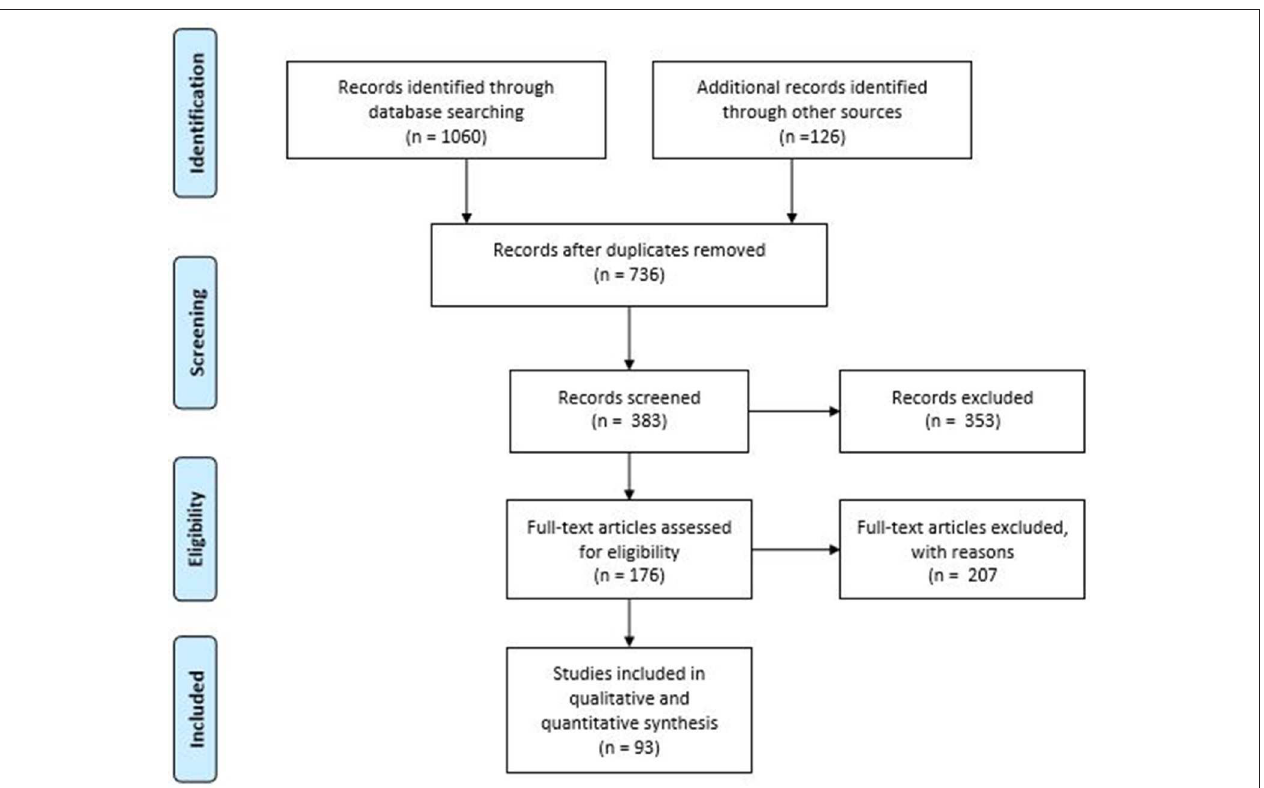
FIGURE 1 | PRISMA flow chart of included studies in the systematic review.